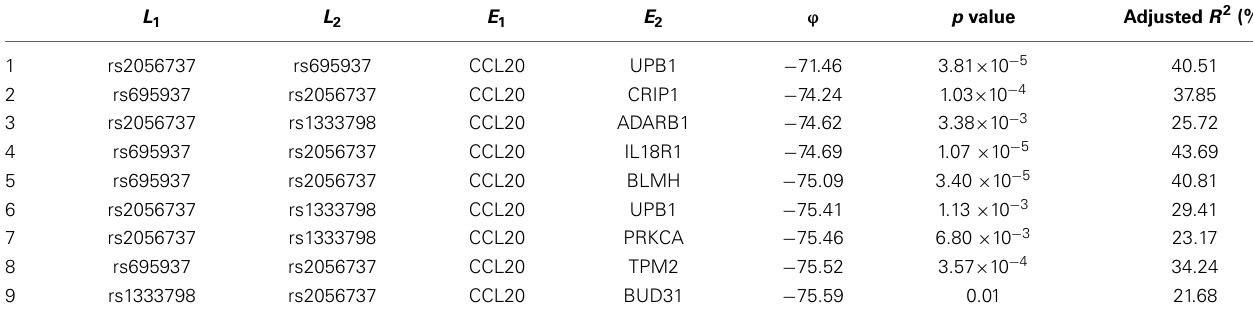
Table 4 | Top scoring five-node subnetworks for